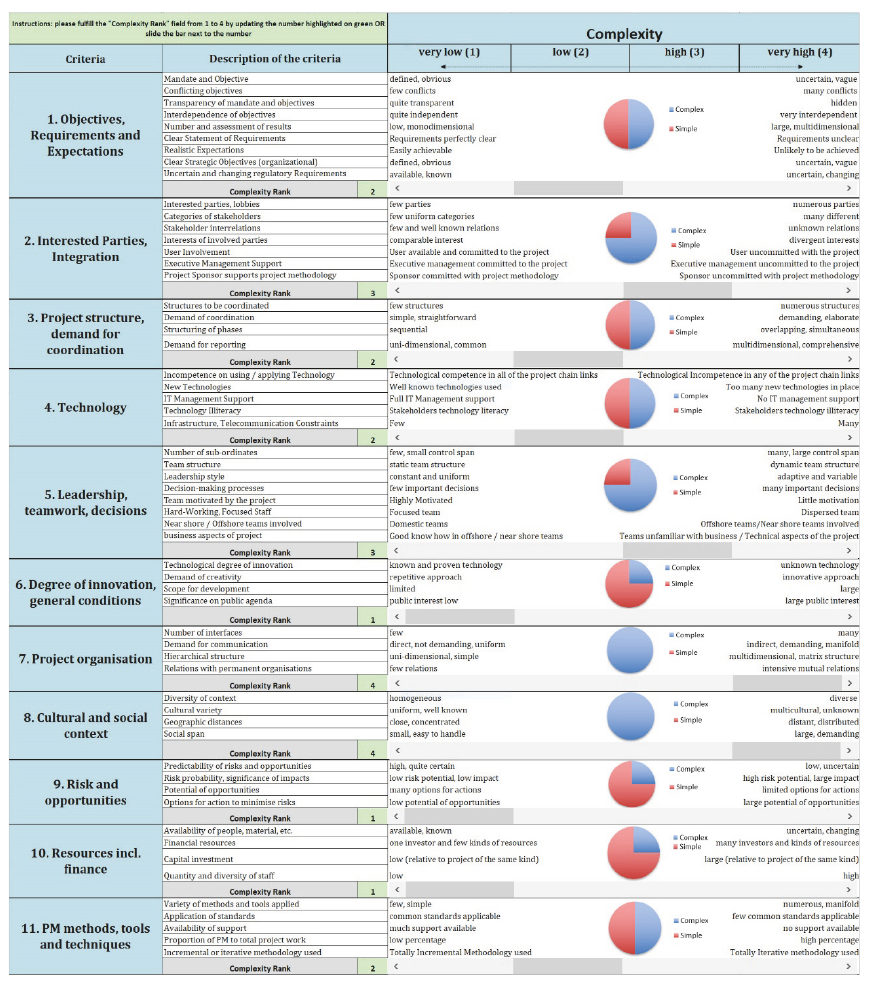
Figure 9: 2015 project assessment with Complexity Index tool.